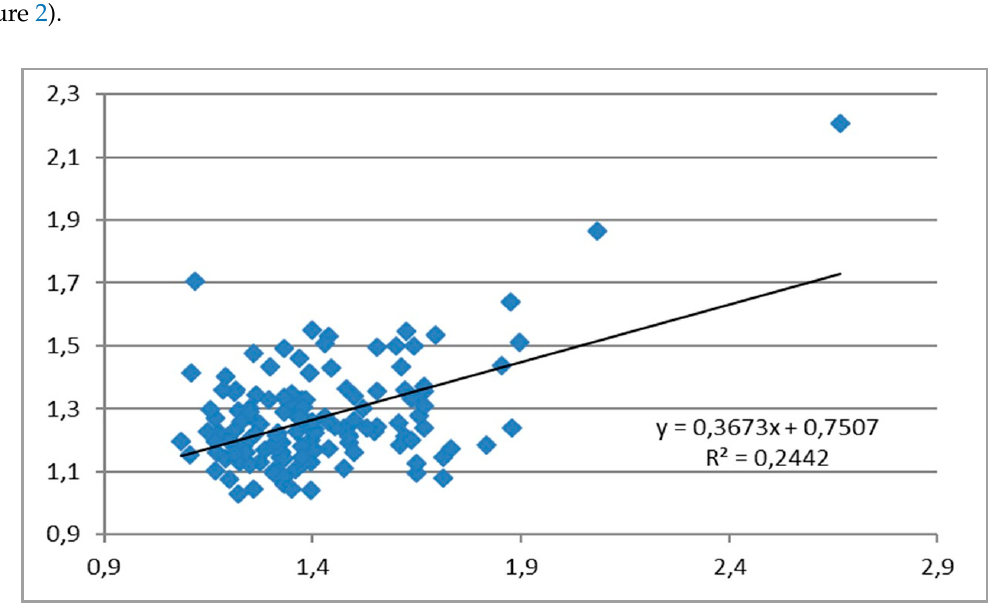
Table 1. Comparative data for patients with and without morbid obesity. N: Number of patients included in each group; BMI: Body mass index; ULBT: Upper lip bite test; HMD: Hyomental distance; clin: Clinical measurement; echo: Ultrasound measurement; p -values derived from t-test for continuous data and Chi-squared test for frequencies.